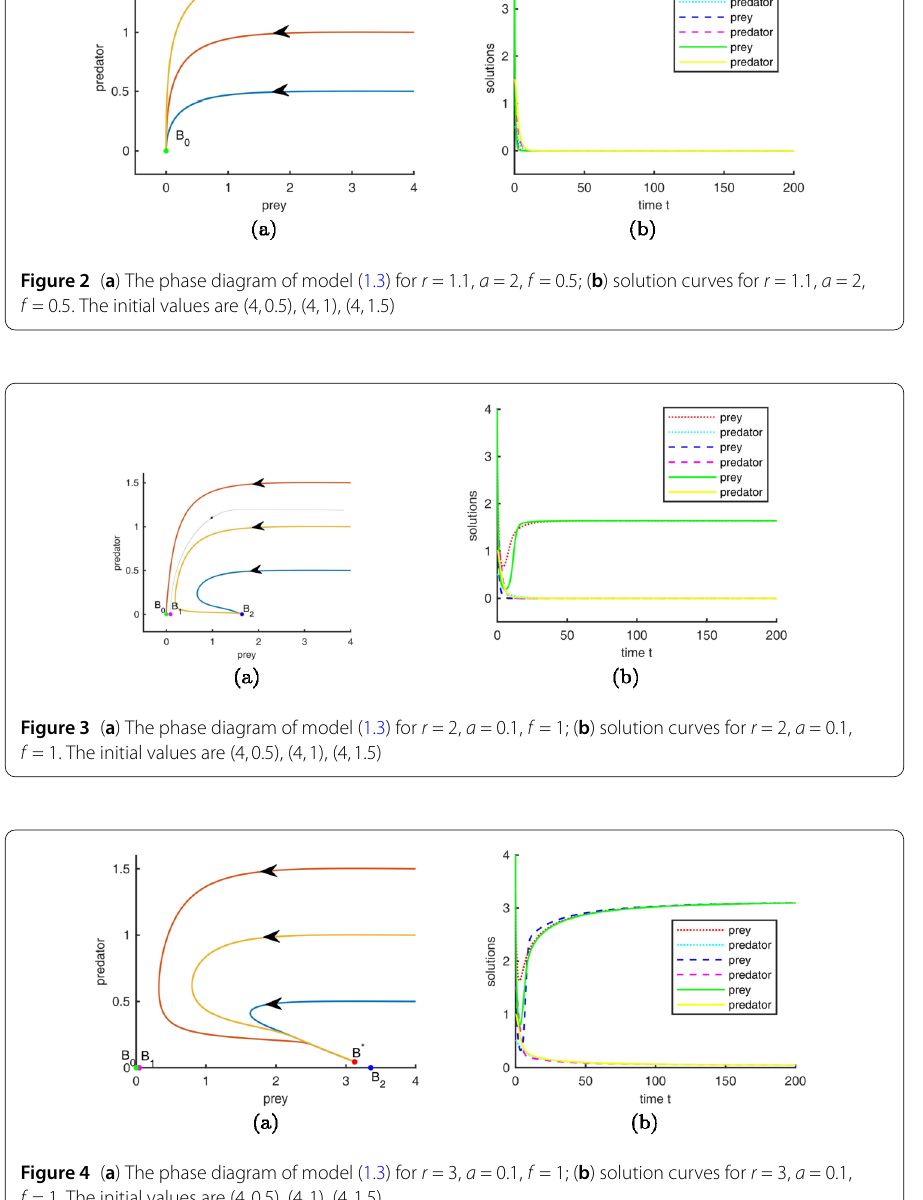
initial value of population density of prey falls in the attraction regions of B 2 , the preda- tor population will die out as t approaches infinity. The simulation results are shown in Fig. 3. Example 4.3 Set r = 3, a = 0.1, f = 1, then a 2 = 6.5104, r 1 = 2.8638, r 2 = 5.3409 and 0 < a < a 2 and r 1 < r ≤ r 2 . From Theorem 2.3, the model (1.3) gets unique coexistence equilibrium B ∗ = (3.125,0.0423), which is locally asymptotically stable, The simulation re- sults are shown in Fig.